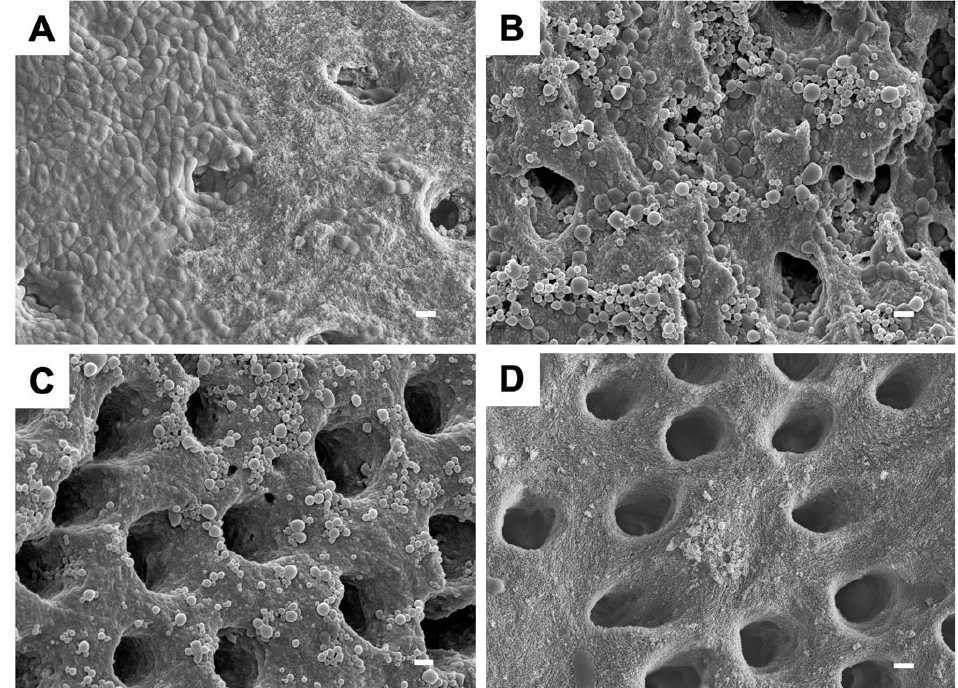
Figure 4. Scanning electron microscope images of E. faecalis biofilm after aPDT/PACT and NaOCl treatments. ( A ) Biofilm without irradiation is shown as a control. ( B ) Biofilm after aPDT/PACT with laser irradiation at 0.7 W. ( C ) Biofilm after aPDT/PACT with laser irradiation at 2.1 W (1.46 W/cm 2 ). ( D ) Biofilm after treatment with NaOCl. All images are displayed at a magnification of ×5000. The length of the bar represents 1 µm.